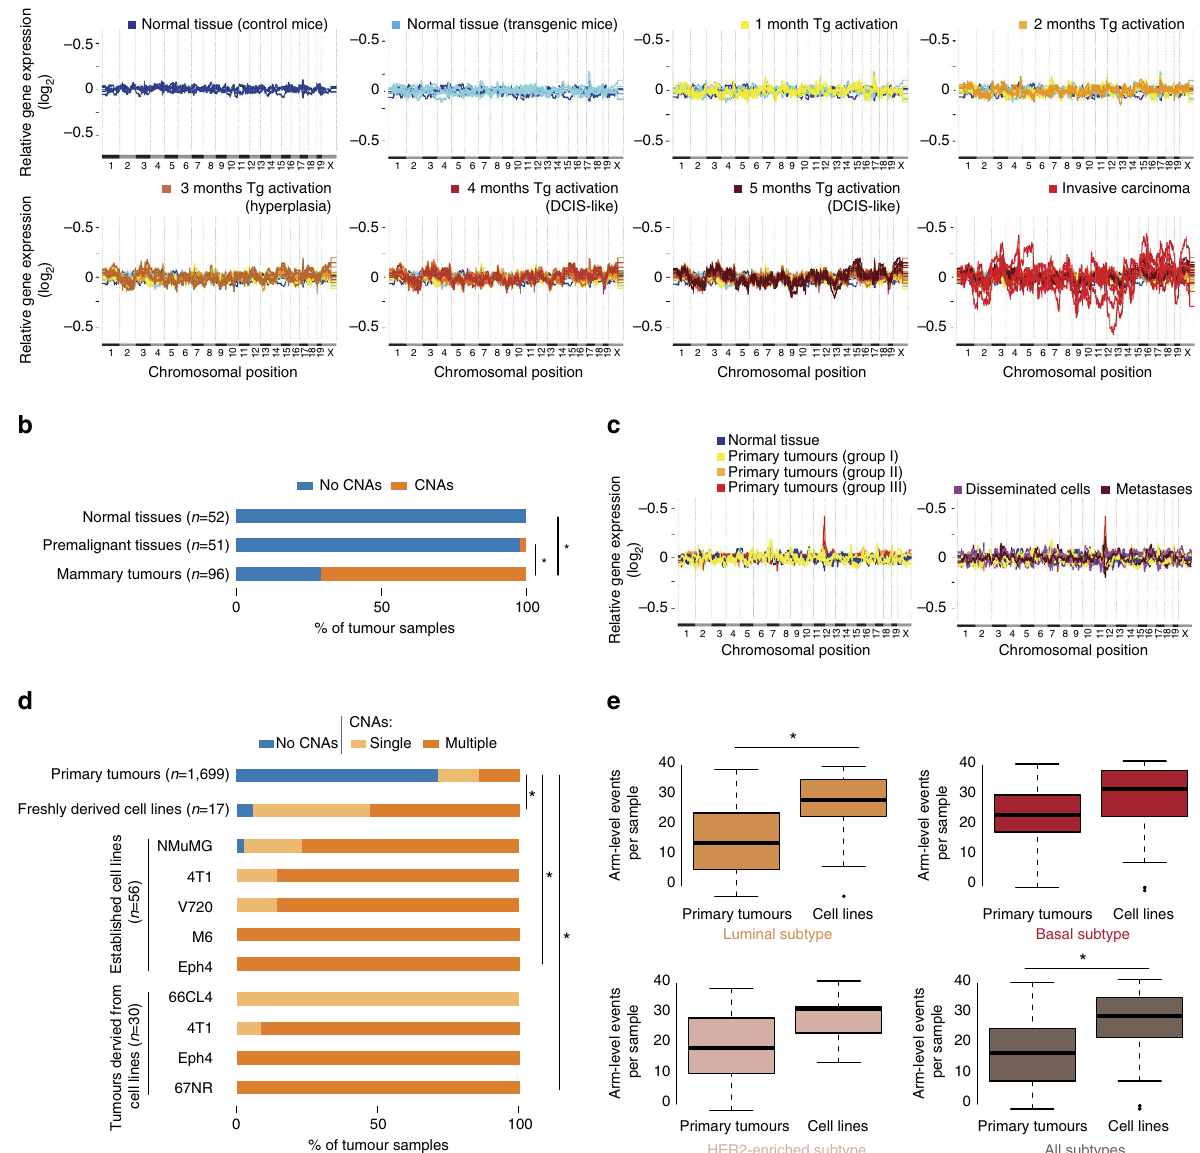
Figure 2 | Chromosomal aberrations are a late event in breast cancer tumorigenesis and further aberrations are acquired during the derivation of cell lines. ( a ) Following chromosomal aberrations in the SV40Tag mouse model (GSE21444) reveals that large CNAs characterize the progression of non- malignant lesions to invasive carcinomas. Presented are moving average plots of gene expression profiles from various stages of tumour development. ( b ) Quantification of the prevalence of chromosomal aberrations in normal tissues (0/52), premalignant tissues (1/51) and invasive carcinomas (68/96) derived from the SV40Tag mouse model. * P ¼ 1.7 (cid:3) 10 (cid:2) 15 and * P o 1 (cid:3) 10 (cid:2) 16 ( w 2 -test) for the comparison of tumours to normal and to premalignant tissues, respectively. ( c ) Following chromosomal aberrations in the PyMT mouse model (GSE43566) reveals that metastasis is not associated with an increased burden of aneuploidy and large CNAs. Presented are moving average plots of gene expression profiles from primary tumours (left; one aberration detected in 11 samples), and from disseminated cells and metastases (right; two aberrations detected in 22 samples). ( d ) Quantification of the prevalence of chromosomal aberrations in primary tumours ( n ¼ 1,699), freshly derived cell lines ( n ¼ 17), established cell lines ( n ¼ 56) and cell line-derived tumours ( n ¼ 30), revealing that cell lines exhibit an increased degree of chromosomal instability. * P ¼ 2 (cid:3) 10 (cid:2) 10 , * P o 1 (cid:3) 10 (cid:2) 16 and * P ¼ 2 (cid:3) 10 (cid:2) 11 ( w 2 -test) for the differences between primary tumours and freshly derived cell lines, established cell lines and cell line-derived tumours, respectively. Single, 1 CNA detected; multiple, 4 1 CNA detected. ( e ) Box plots presenting the number of arm-level CNAs in human primary breast tumours (from The Cancer Genome Atlas) and in human breast cancer cell lines (from the Cancer Cell Line Encyclopedia), divided by molecular subtype. * P ¼ 1.2 (cid:3) 10 (cid:2) 4 and * P ¼ 9.7 (cid:3) 10 (cid:2) 7 (Student’s t -test) for the luminal subtype and for all subtypes combined, respectively. Boxes show the median, 25th and 75th percentiles, lower whiskers show data within 25th percentile (cid:2) 1.5 times the IQR, upper whiskers show data within 75th percentile þ 1.5 times the IQR and circles show outliers. See also Supplementary Figs